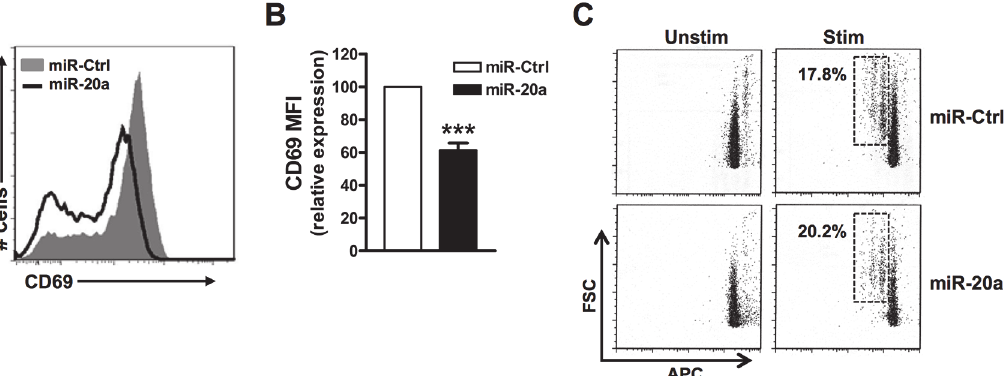
Fig 5. miR-20a inhibits early T-cell activation events. Human na ï ve CD4 + T cells were transfected with either miR-20a or miR- control expression plasmids. (A) 16h after transfection, cells were stimulated with immobilized CD3xCD28 mAbs for 6 hours and stained with an APC-conjugated CD69 mAb. Surface expression of CD69 was measured by flow cytometry. One representative experiment of 4 is shown. Graph in ( B ) represents relative mean fluorescent intensity (MFI) of CD69 expression of miR-20a overexpressing cells compared to miR-control. (C) Alexa Fluor 700 labelled cells were either left unstimulated or stimulated with platebound CD3xCD28 antibodies for 60 hours. Proliferation of cells was then analysed by flow cytometry by measuring the dilution of the fluorochrome by gating on GFP+ cells. Data represent arbitrary units ± SEM of at least 3 independent experiments. Significat P values were done by using Student ’ s t Test. ( *** , P <